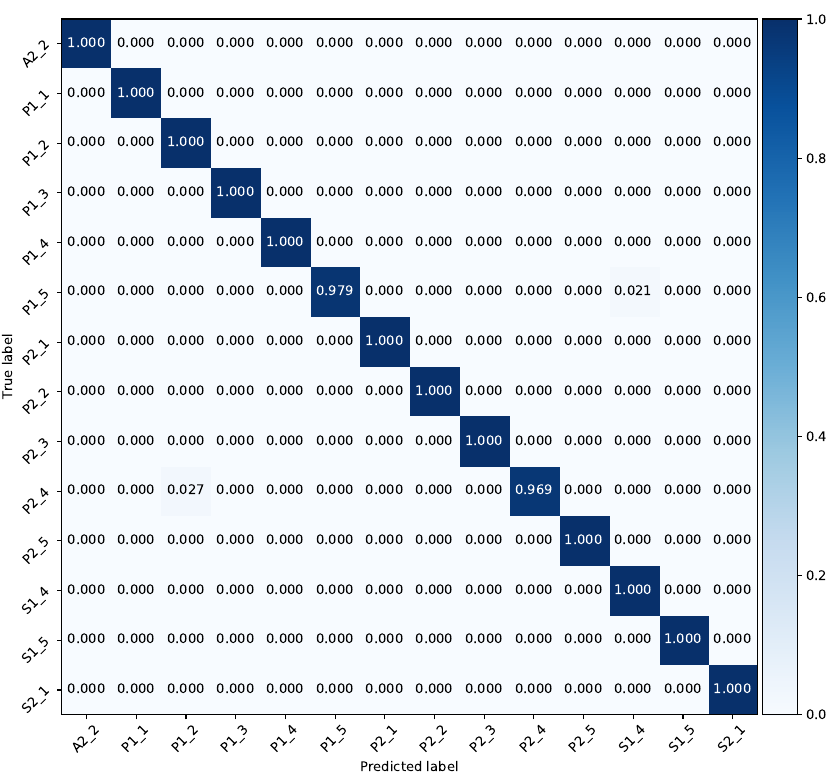
Figure 8. Normalized confusion matrix of the proposed model evaluated on test set of the Praxis